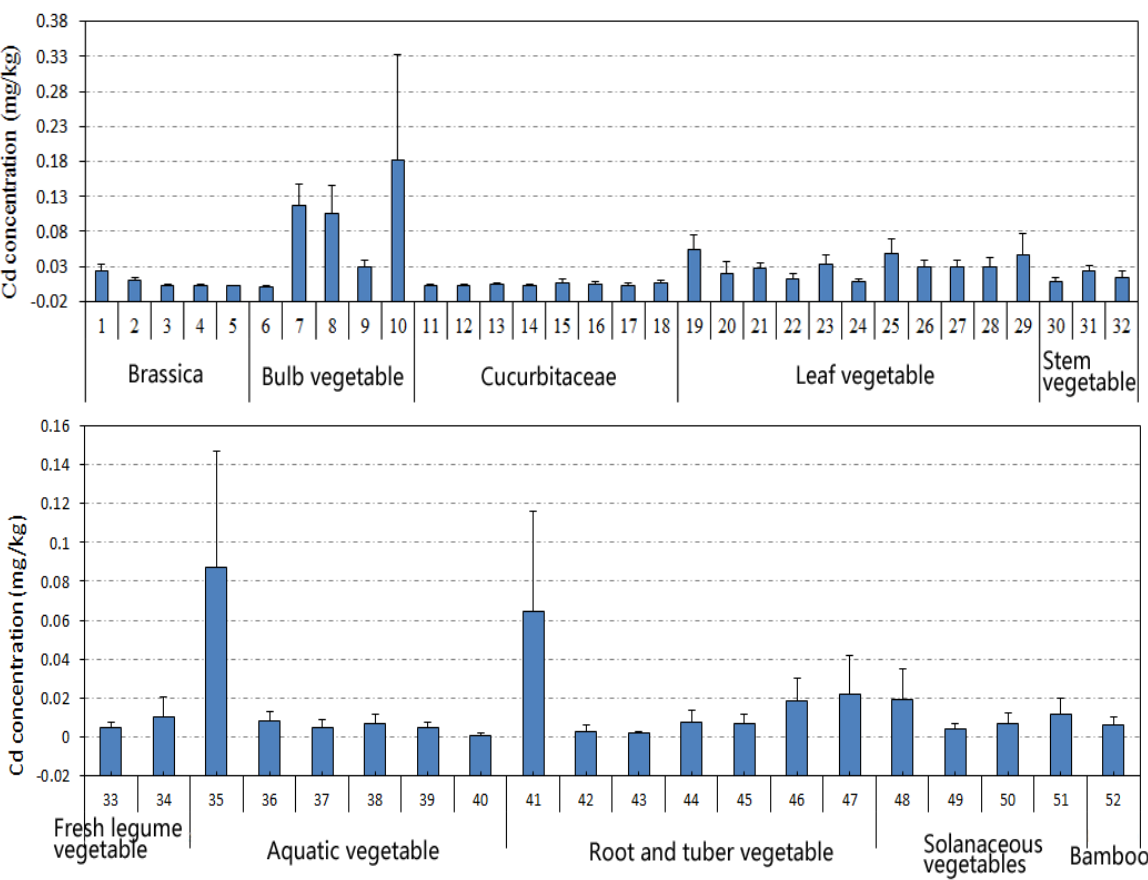
Figure 2. Cd levels in different vegetables. (1) Brassica campestris L., (2) broccoli , (3)